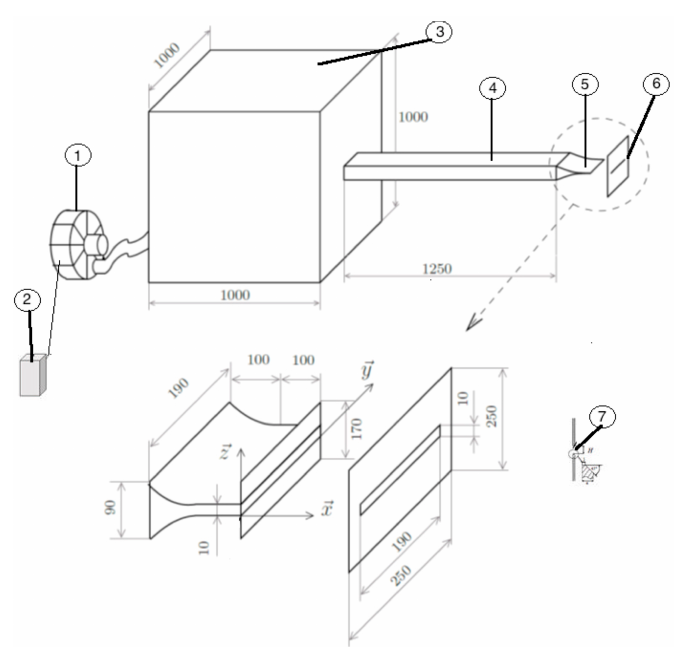
Figure 4. Schematic description of experimental Set